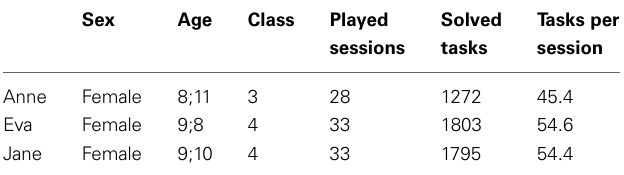
Table 4 | Characteristics of the three example